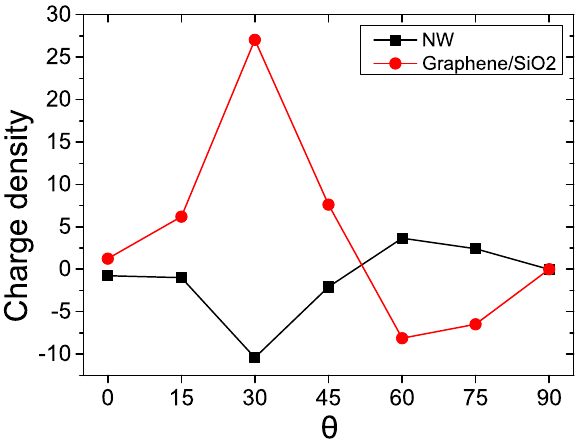
Figure 6: Integrated vertical dipole charge on x - y plane of surface of section ( z = 0) of graphene-coupled NW hybrid gap structure with different incidence